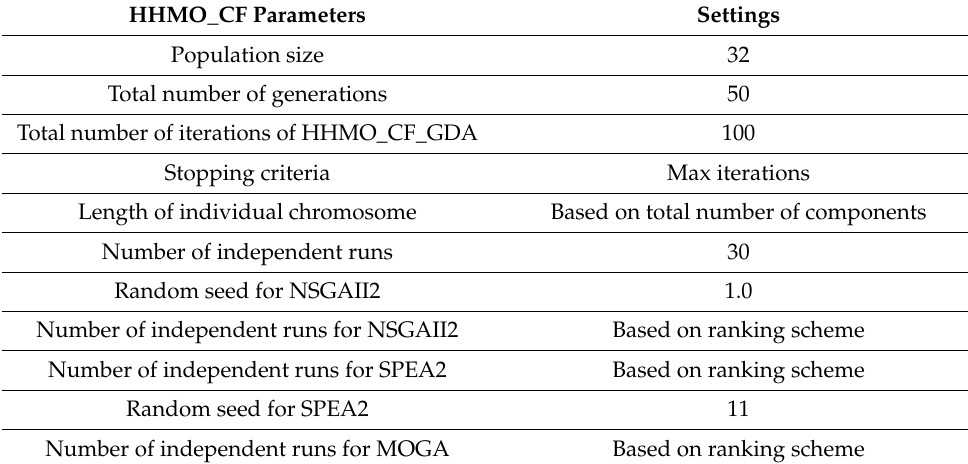
Table 6. Parameter settings of HHMO_CF_GDA and low-level heuristics. HHMO_CF Parameters